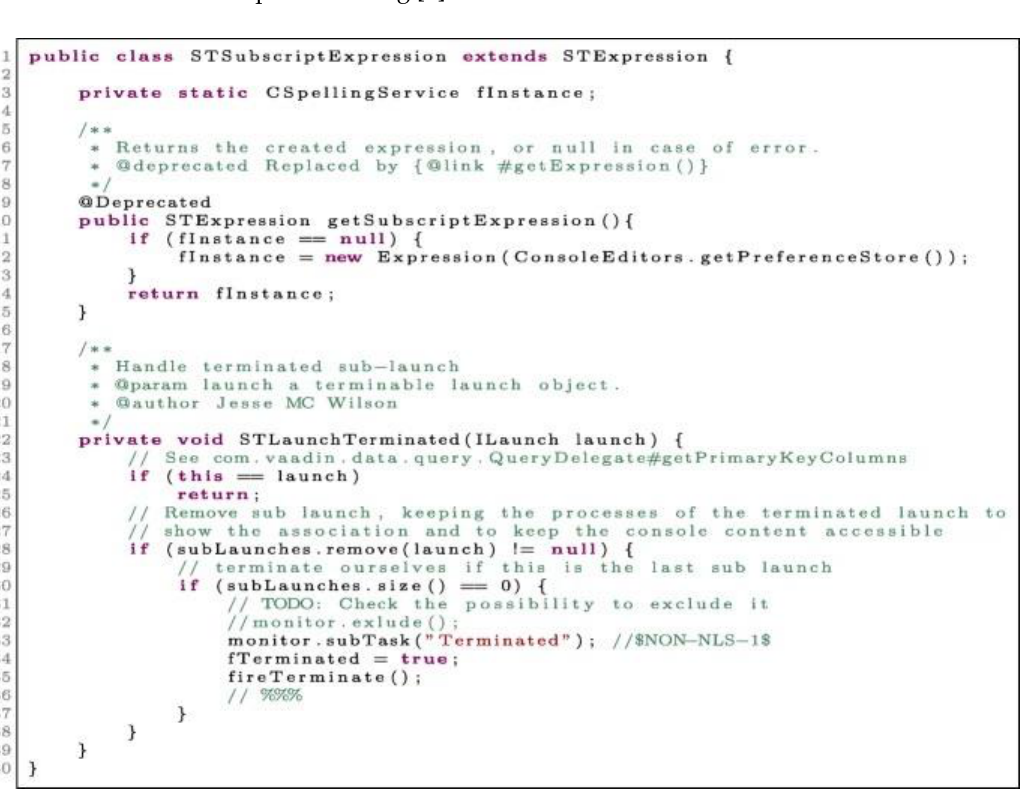
Figure 1. Example of code comments in Java program file. Reprinted/adapted with permission from [8] Copyright 2019, by Luca Pascarella, Magiel Bruntink, Alberto Bacchelli .